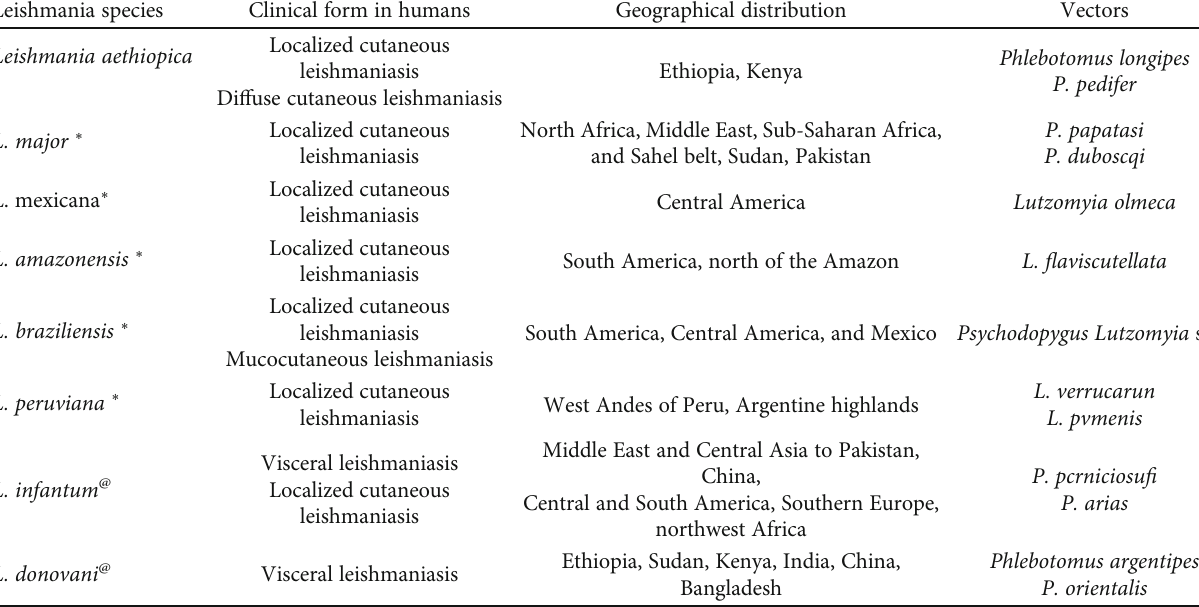
Table 1: Leishmania species, the disease form they can cause, their geographical distribution, and vectors are summarized. Leishmania species Clinical form in humans Geographical